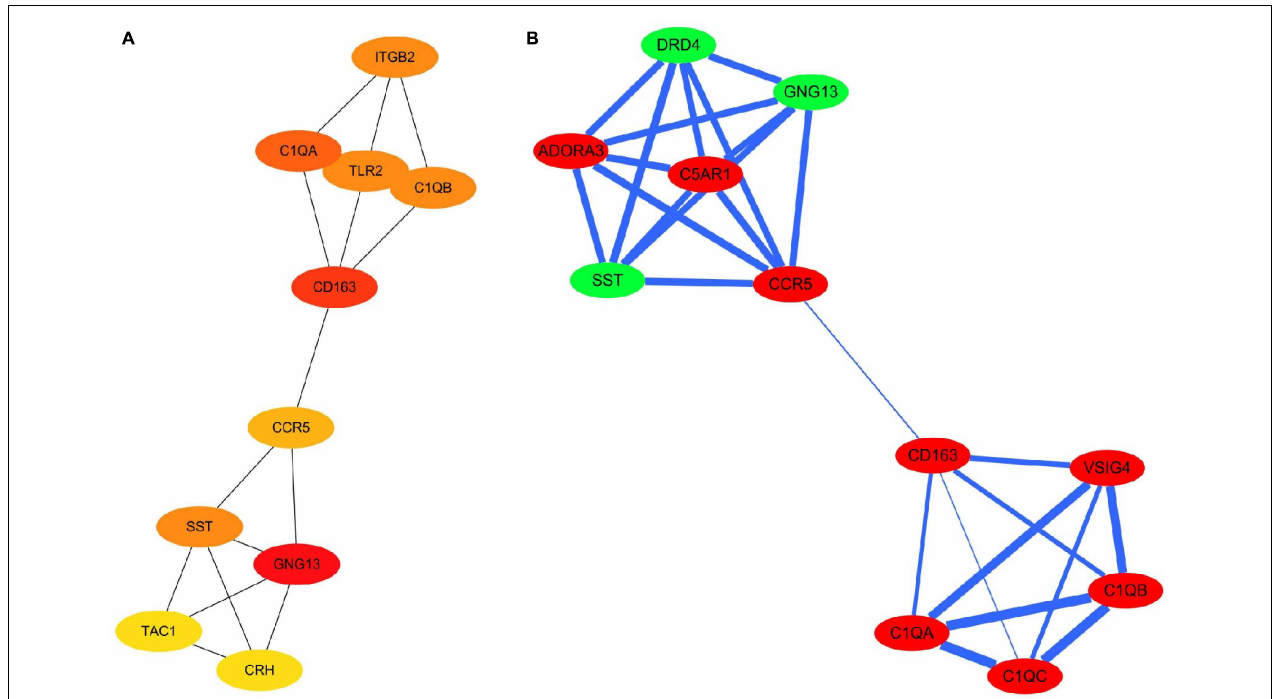
FIGURE 5 | Hub genes and modules identified in the protein–protein interaction network visualized using Cytoscape software. (A) Top 10 hub genes with a higher degree of connectivity. (B) Sub-network with the highest MCODE score is shown. Green indicates downregulated genes; red indicates upregulated genes. The width of the blue line indicates the combined score obtained using the STRING database.